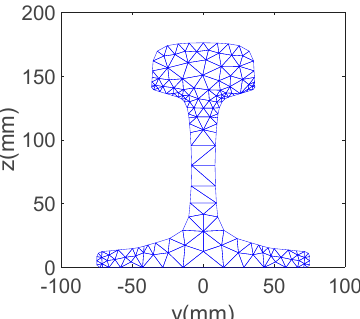
Figure 2. Discretization of triangle elements.